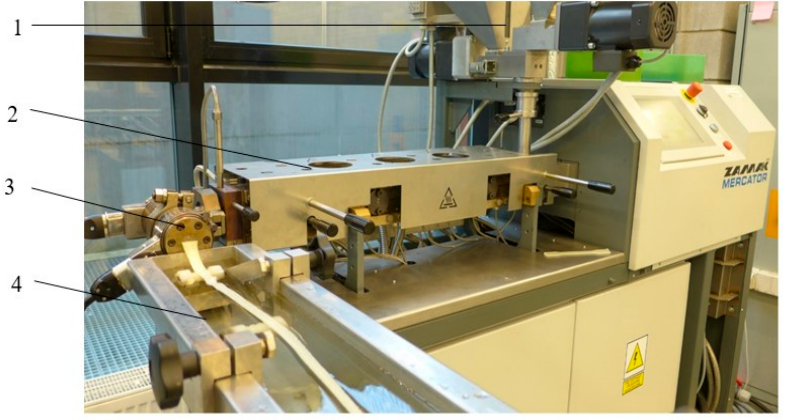
Figure 1. Twin-screw extruder machine: 1—dosing device, 2—plasticizing system, 3—extruder head, 4—cooling device.